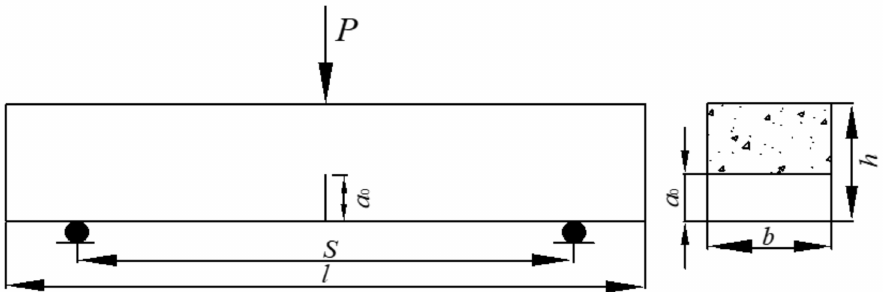
Figure 1. Sketch of the specimen’s shape and